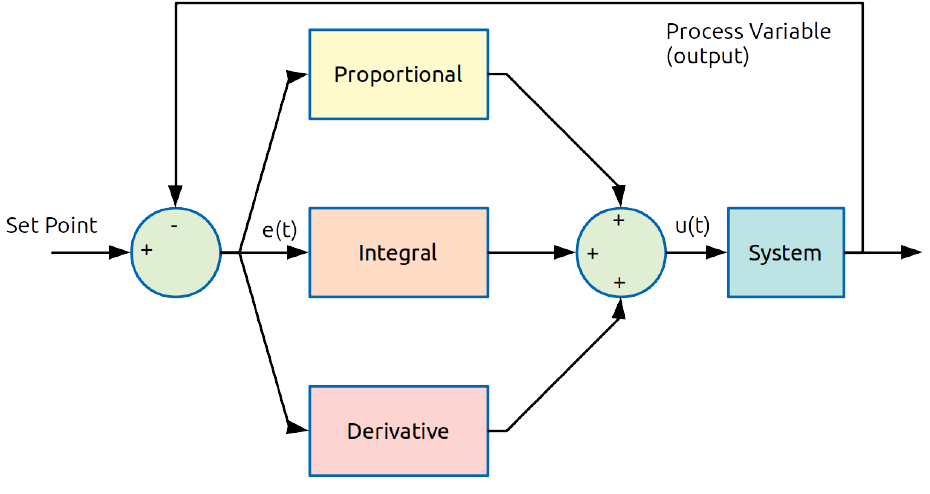
Figure 1. Flow diagram of the proportional–integral–derivative controller (PID) controller. The time t -dependent error function, e ( t ) , is the difference between the set-point (SP) and a measured process variable (PV). The weighted average of the P, I, and D contributions determines the output control, u ( t ) , for the specific system to be